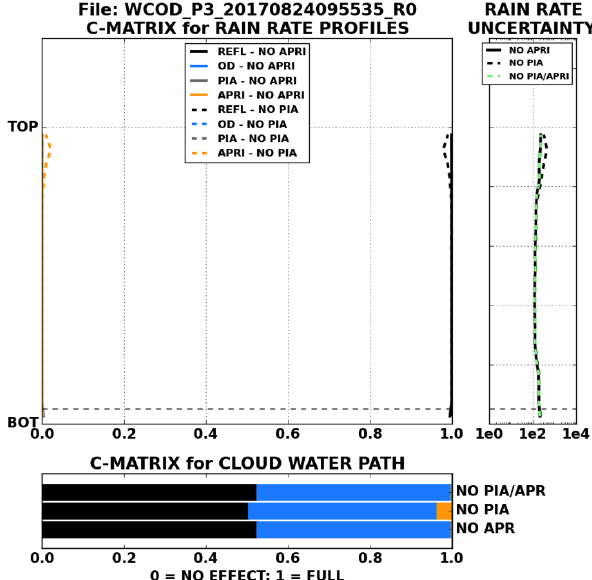
Figure 4. As in Fig. 3 but for profiles where the a priori constraint contributed minimal uncertainty (solid line) and profiles where the a priori or PIA constraints contributed minimal uncertainty (dashed